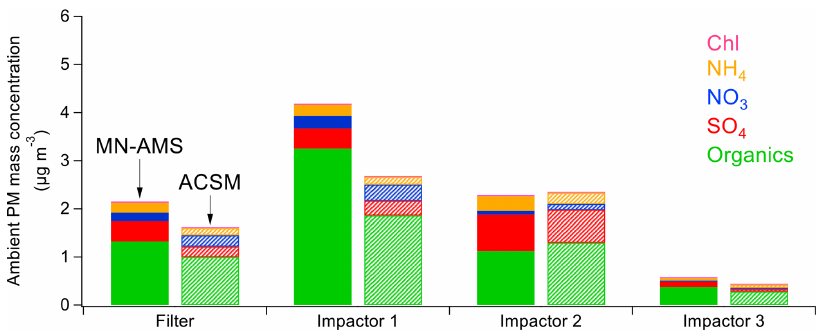
Figure 6. Comparison of the ACSM-measured ambient NR-PM 1 mass concentration and the MN-AMS back-calculated ambient NR-PM 2 . 5 mass concentration at the SGP site. Sampling time periods for the filter and impactors are shown as shaded areas in Fig. 5a.